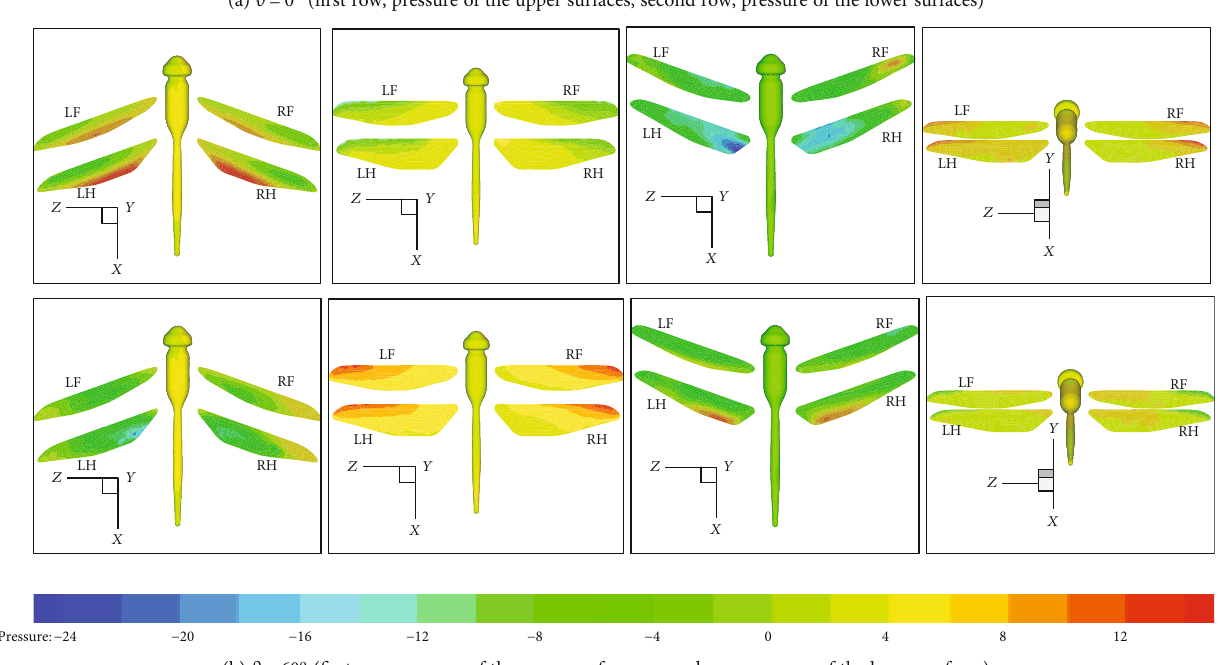
Figure 11: Pressure distribution at various times in one